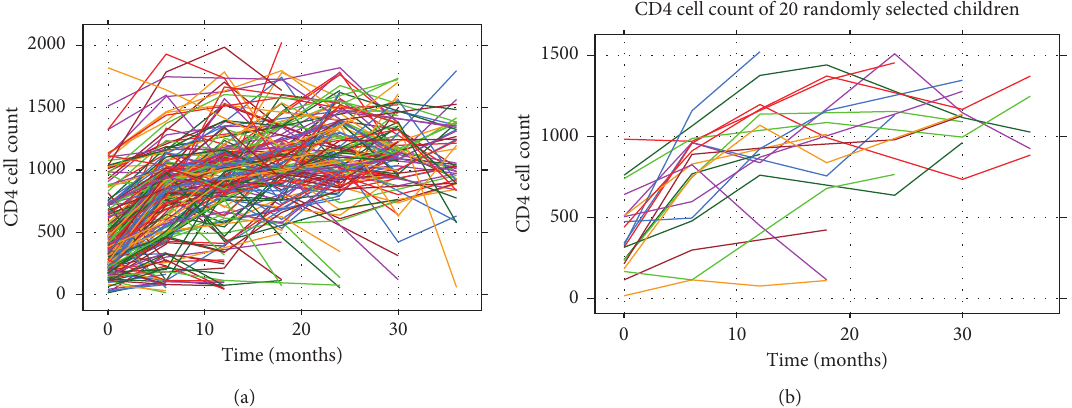
Figure 1: Individual profile plot of the CD4 cell count of all samples (left) and twenty randomly selected children’s by the follow-up time (right).